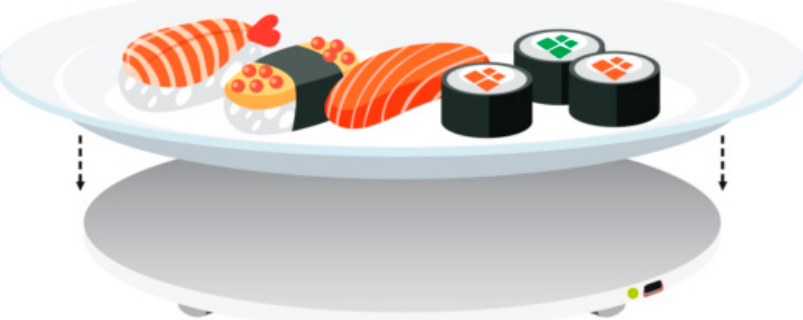
Figure 5. A custom-made electronic scale that is connected via bluetooth with a smartphone application measuring the reduction of the food placed on the scale along with self-recording of hunger and fullness [54].